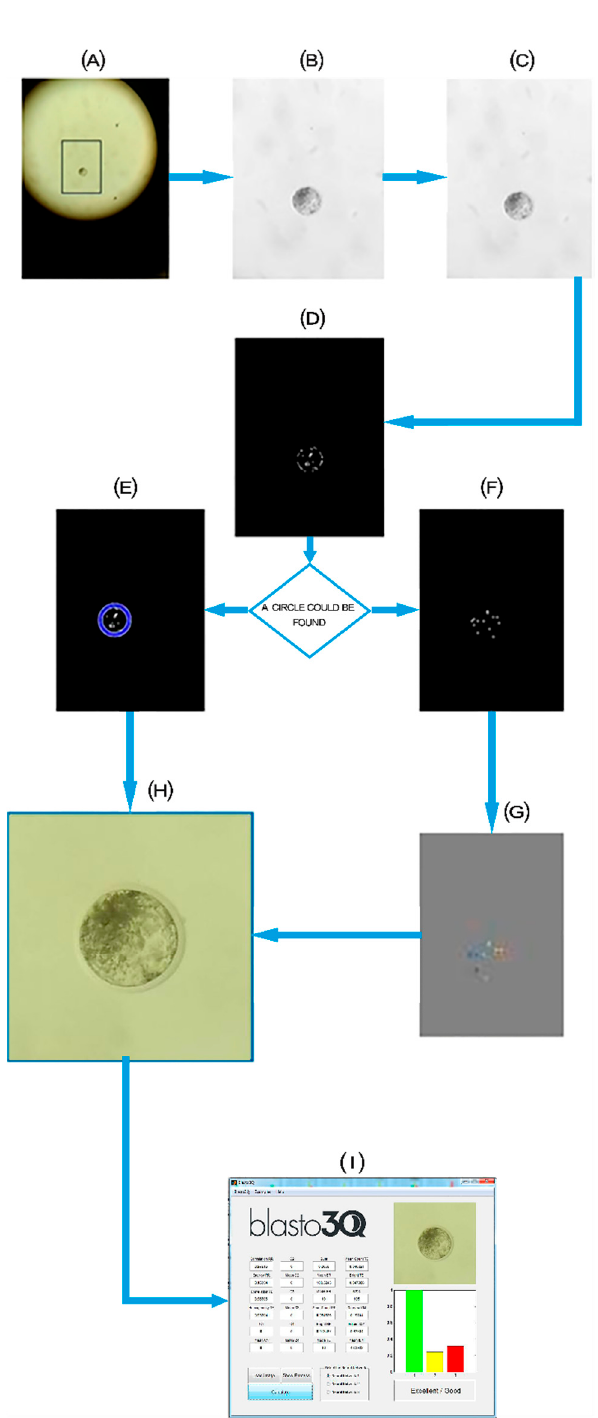
Figure 2. Flowchart of the scaling algorithm software processing steps. ( A ) Originally obtained image with the embryo inside the box; ( B ) conversion of image (A) to grayscale; ( C ) adjustment of the image intensity values; ( D ) binary image; ( E ) Circular Hough transform; ( F ) image obtained with distance transform; ( G ) Watershed transform; ( H ) re ‐ scaled image (expanded); and ( I ) user interface of the Blasto3Q software after expanded image grading.